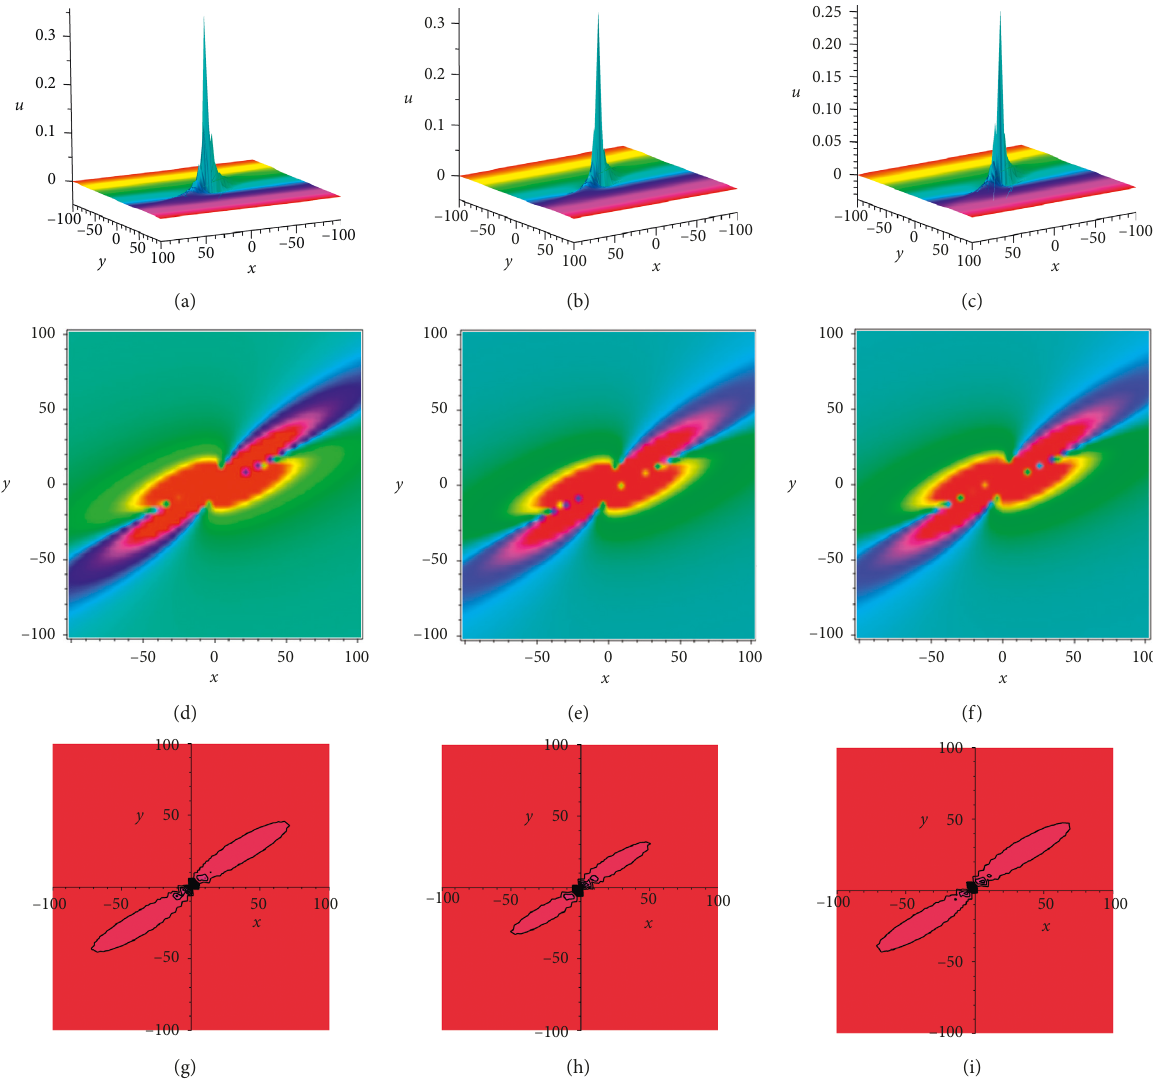
Figure 1: 3D plots, density plots, and contour plots of lump wave solution (19) with the specific parameters � 2 ,a � 1 ,a � 1 , b � 1 ,b � 1 , b � 1 , α � − 1 , and β � 2. (a), (d), and (g) are for t � − 2; (b), (e), and (h) are for t � 0; (c), (f), and (i) are a 1 3 4 1 3 4 for t �